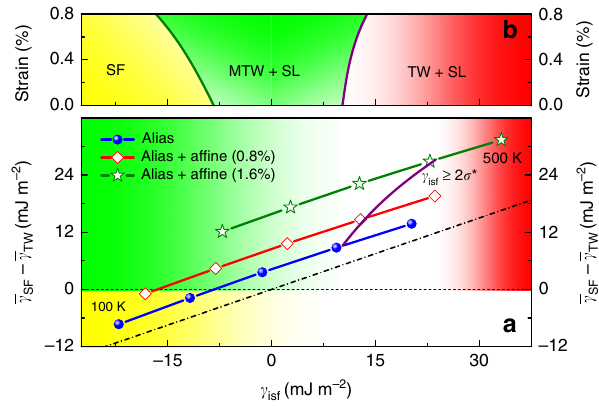
Fig. 5 Deformation modes for the Fe 40 Mn 40 Co 10 Cr 10 alloy as a function of intrinsic stacking fault energy ( γ ). Panel a shows the effective energy isf barrier difference for temperatures between 100 and 500 K, and for three different af fi ne shear strains. The dash-dot lines marks the ideal relation γ = 2 (i.e., the δ = 0 case). The solid line is the approximate ¼ γ þ γ utf usf isf boundary between metastable twinning (green area) and normal twinning (red area) regions in terms of γ . Martensitic transformation (yellow area) isf occurs for γ < − 8.4 mJ m − 2 for the strain-free case, and this boundary is isf shifted towards lower values with increasing af fi ne strain. The schematic deformation mode diagram shown in panel b is based on the theoretical data obtained for Fe 40 Mn 40 Co 10 Cr